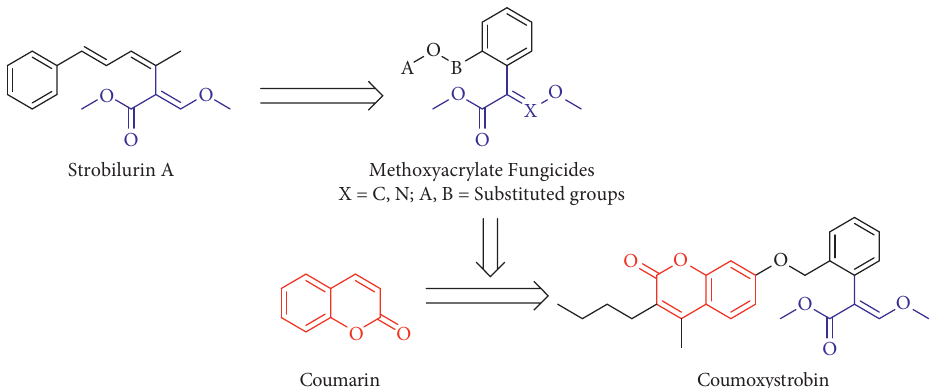
Figure 1: Methoxyacrylate fungicides and coumoxystrobin successfully developed based on natural product strobilurin